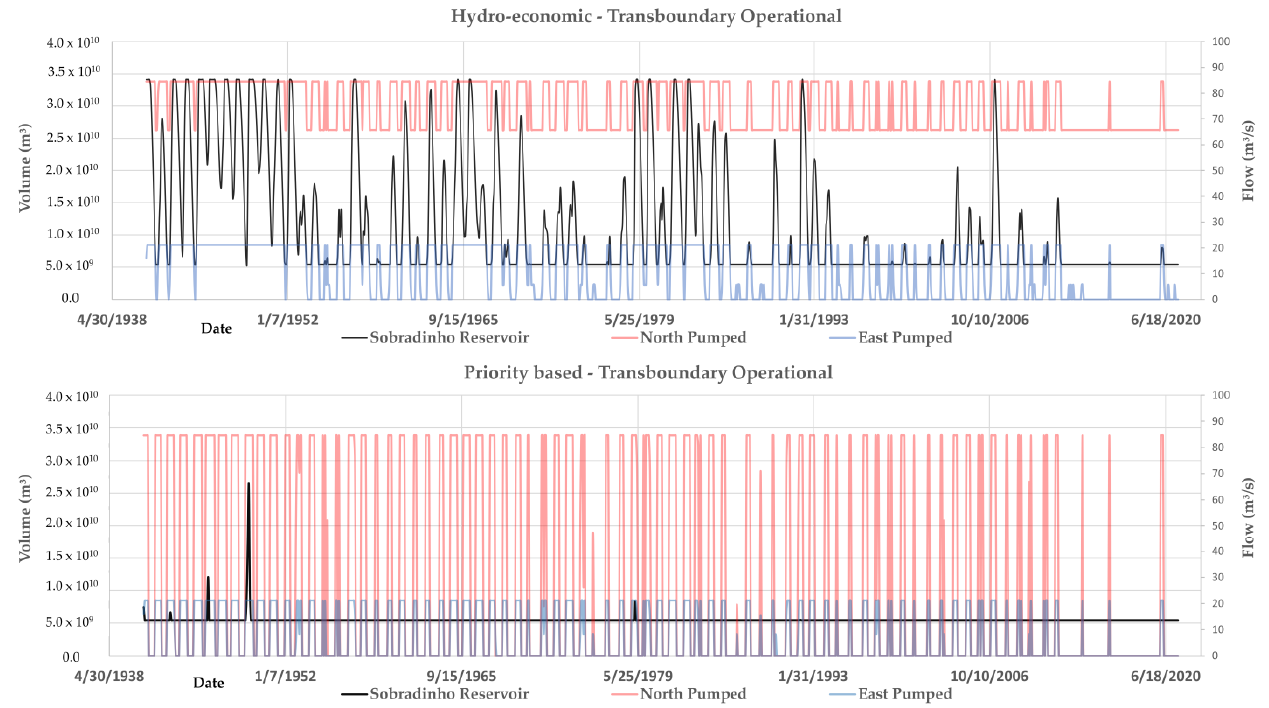
Figure 9. Operation of the Sobradinho reservoir without using the operational rule, based on the results of applying the AcquaNetGIS model.